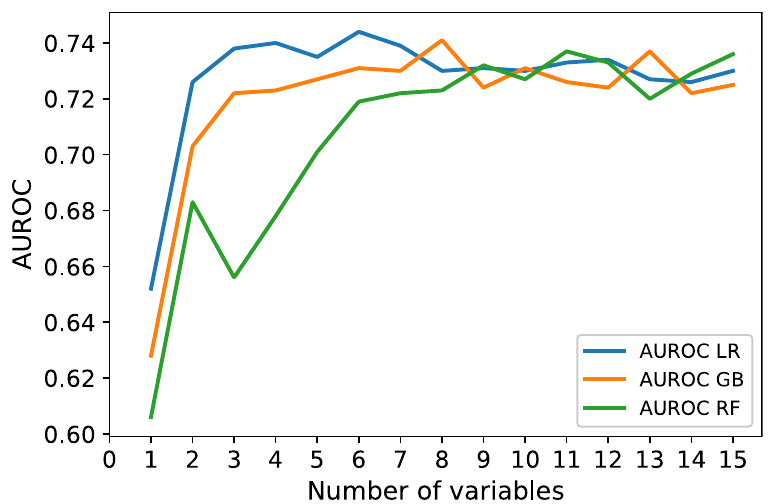
Fig 4. AUROC values as a function of the number of variables used to predict revision ESS. We used three models and the classifiers in these models were logistic regression, gradient boosting and random forest for predicting revision ESS. AUROC, area under the receiver operating characteristics curve; ESS, endoscopic sinus surgery.